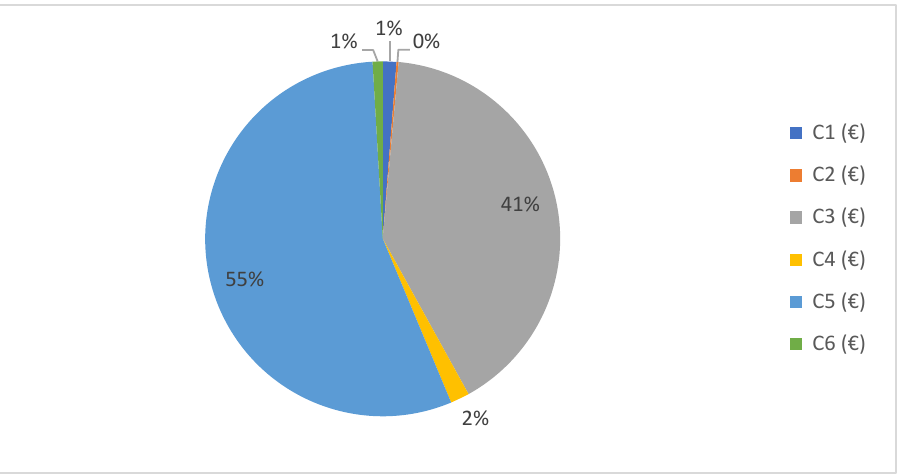
Figure 2. Floating wind map in Spain. (1) Some restrictions present in Spanish waters. (2) Floating wind farm proposed. (3) Ribadeo floating wind farm.